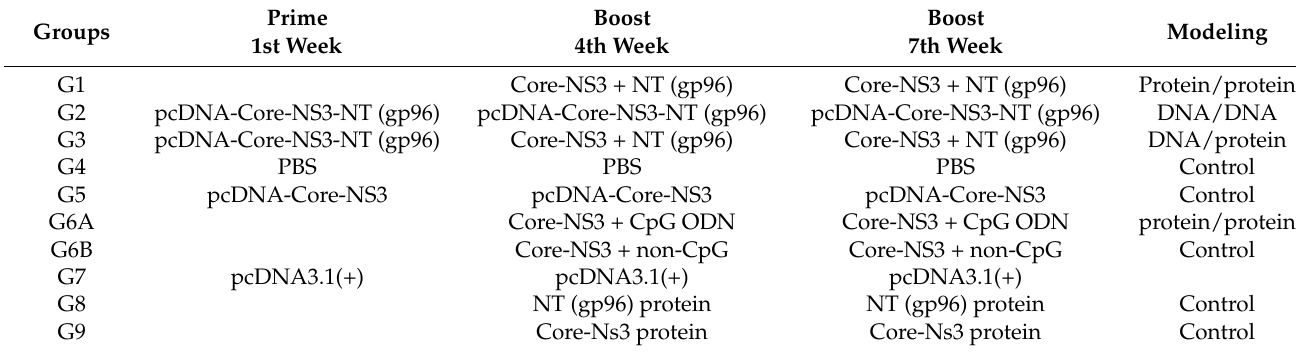
Table 2. Immunization schedule in different mice